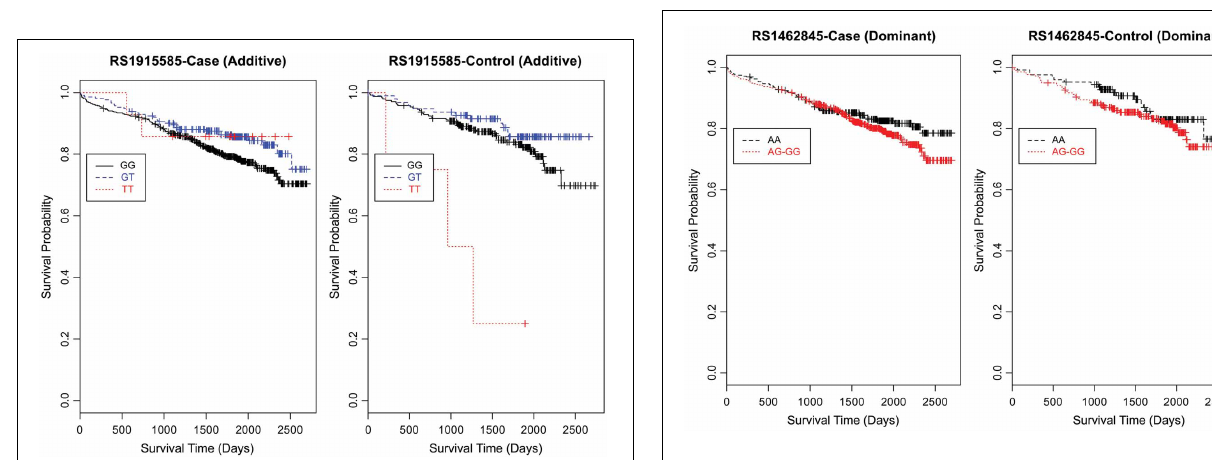
FIGURE 3 | Kaplan-Meier survival curves for CAD cases vs. controls in additive (genotype) model for LSAMP SNP rs1915585. X -axis displays the number of days from index catheterization to death (all-cause mortality). Y -axis displays the Kaplan-Meier survival probability by genotype. T is the minor allele; GG, wild-type genotype (reference, black curve); GT, heterozygous genotype (blue curve); and TT, risk homozygous genotype (red curve).